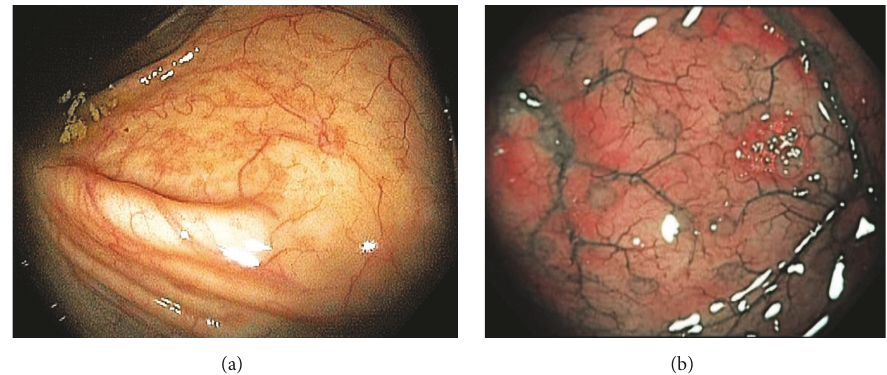
Figure 6: Endoscopic images of the cecum. Normal vascular pattern within the ileocecum consists of branching vascular network within background of pink mucosa and intramural arteries penetrating the colonic wall (a). Gut associated lymphoid tissue is abundant in the ileocecum and they can appear as Peyer’s patches, lymphoid nodules, and periappendiceal and appendiceal lymphoid follicles. These normal findings are best observed under digital chromoendoscopy (b).